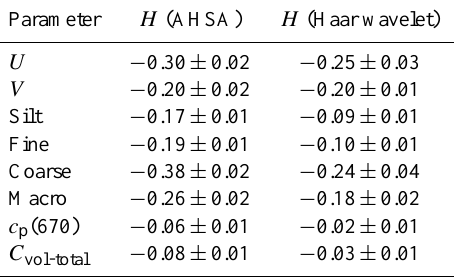
Table 1. The Hurst exponent values derived through AHSA and the Haar wavelet method for various